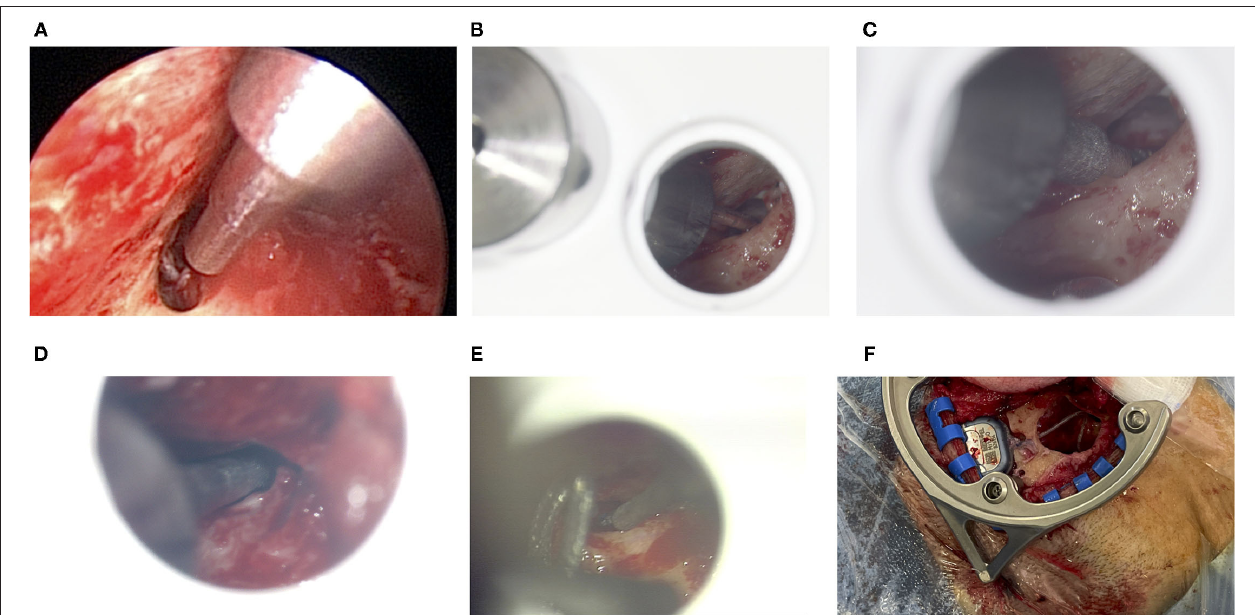
FIGURE 7 | (A) Endoscopic inspection after the facial recess has conventionally been exposed for cochlear implant (CI) surgery for patient 01. The 1.8 mm sham drill bit points through the open facial recess without collisions. The large diameter in the top right of this image is 3 mm, which - in this case - comes close to the thinned out EAC. (B) Microscopic view for patient 03. The 1.5 mm sham drill bit fits through, whereas (C) the 1.8 mm sham drill bit does touch the bony layer above the FN. (D) For patient 04, the 1.8 mm sham drill bit passes through. (E) For patient 05, only the 1.5 mm sham drill bit just passes through very tightly. (F) The geometry of